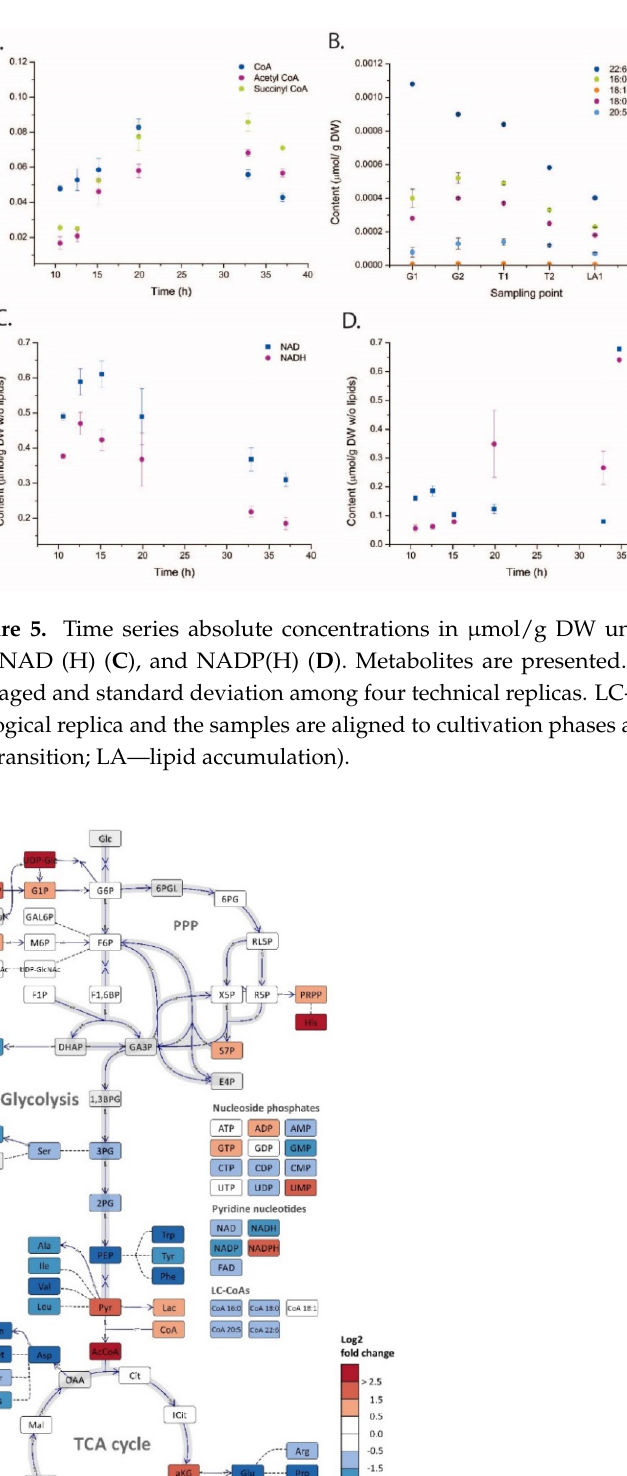
Figure 6. Log 2 ratio of metabolome data of sampling points 32.9 (LA phase) and 12.6 (growth phase) from the Aurantiochytrium sp. T66 cultivation. The figure was prepared using Omix visualization software [38], and data normalized to free available intracellular volume was used. Compartmental- ization of eukaryotic cells is not included. Reactions with two opposite arrows indicate reversible reactions with different enzymes, bidirectional arrows are reversible reactions, dashed lines indicate that intermediates are not included.